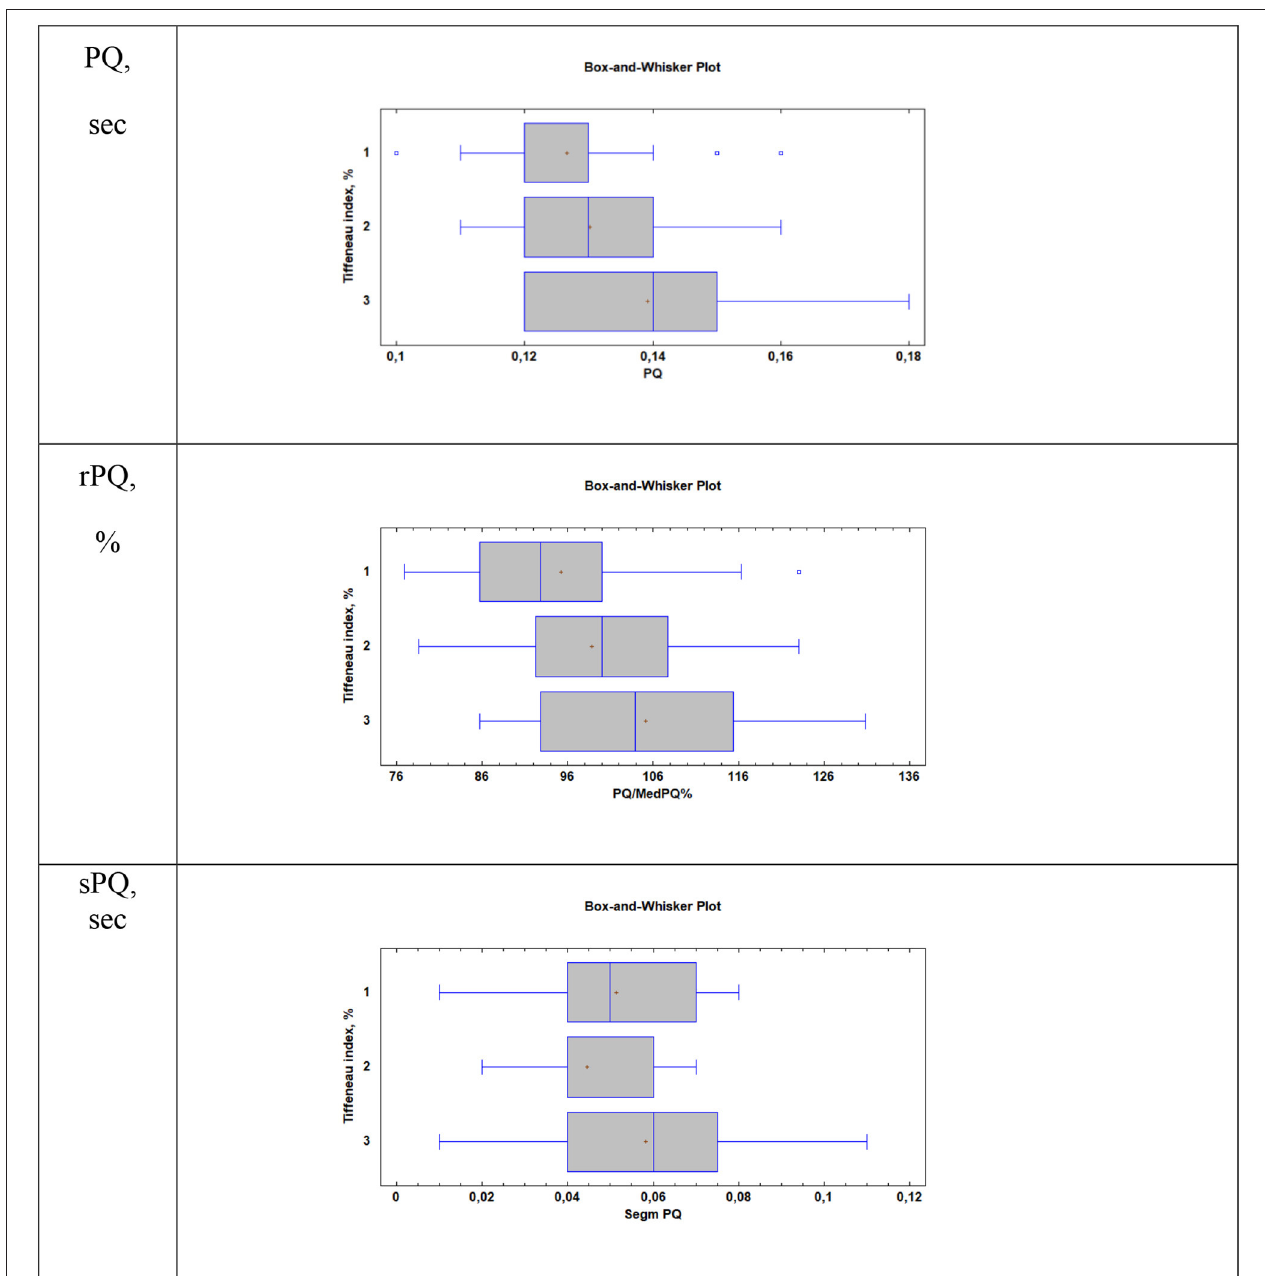
FIGURE 1 | Supraventricular conduction parameters in patients with different values of the Tiffeneau index (R. Tiffeneau) in children with BA. Group 1, Patients with TI > 85%; Group 2, Patients with 75% < TI < 85%; Group 3, Patients with TI < 75%; PQ, sec–duration of PQ interval; rPQ = PQ/PQ med × 100%; sPQ, sec–duration of PQ